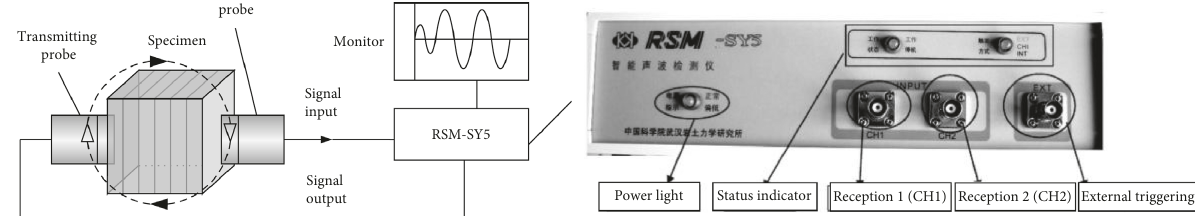
Figure 5: Acoustic wave test.